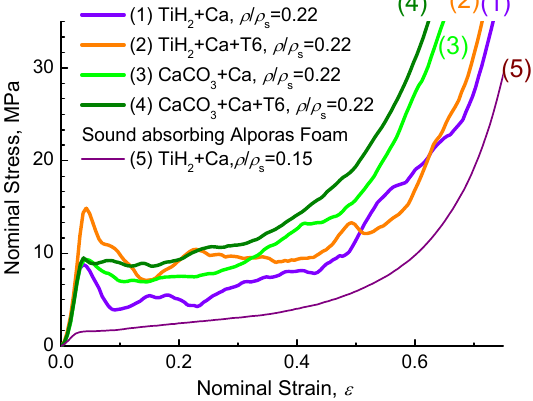
Figure 5. Typical compressive stress-strain curves for different kinds of ZAM 2 alloy foams (1,3) and (2,4) after heat treatment using mode T6 (see subsection 3.2) in comparison with that of (5) Alporas foam.